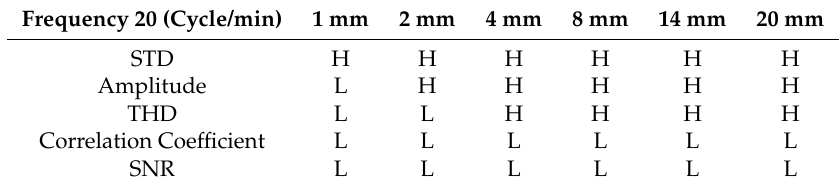
Table A9. Values higher and lower than the median Frequency 20 cycles/min for a 3 mm band.